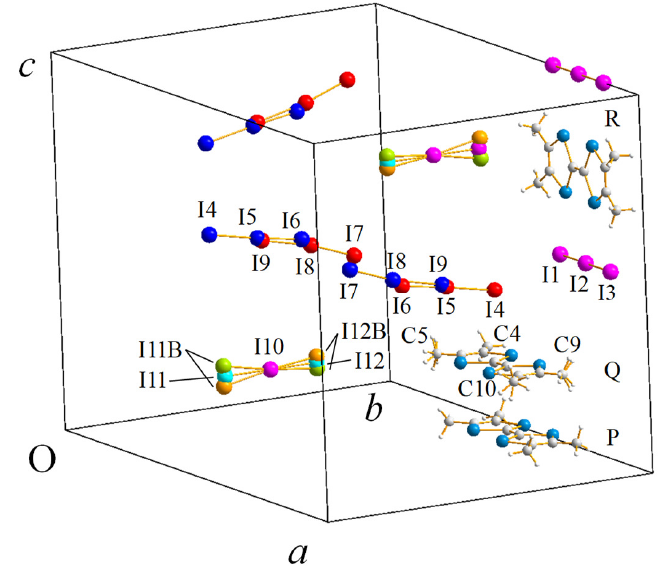
Figure 3. Some molecules in the unit cell of (TMTSF) 8 (I 3 ) 5 selected to show the three types